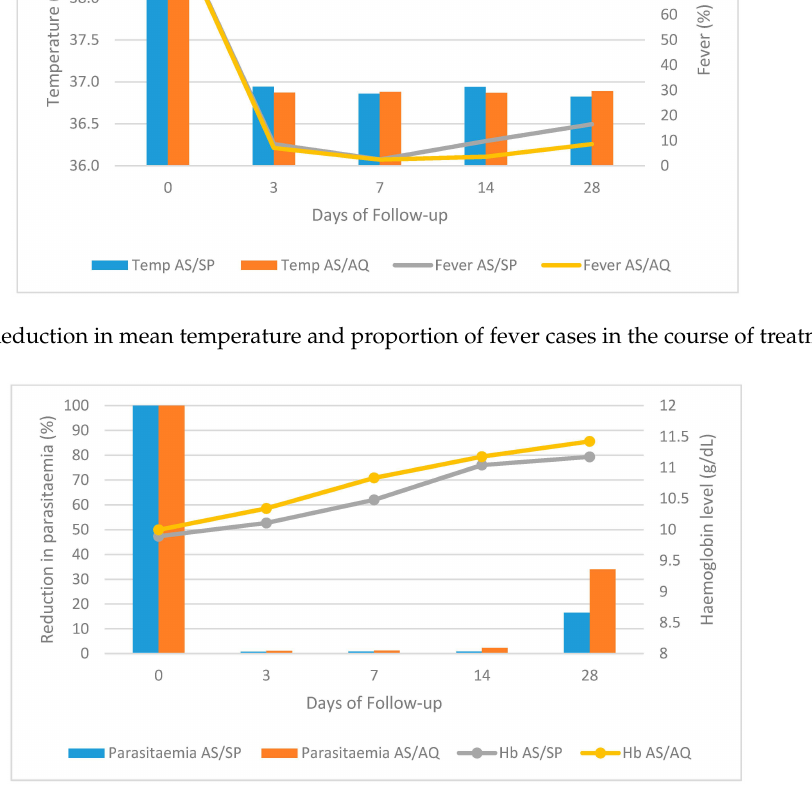
Figure 3. Variation in malaria parasitaemia and haemoglobin level of study participants in the course of treatment.